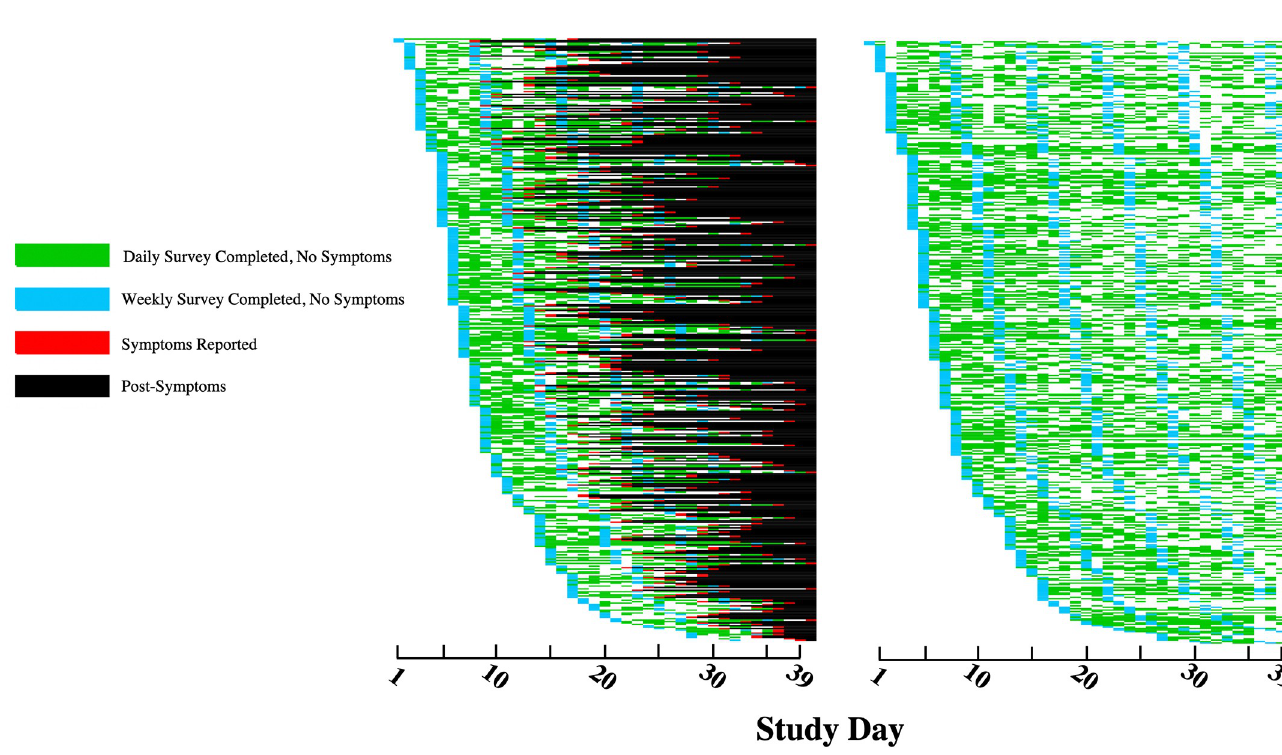
Fig 2. Heat map of symptomatic and sample of asymptomatic patients displaying time of enrollment, survey completion, time of symptom development, and follow-up. The left plot depicts participants that developed symptoms. The right plot depicts participants who did not develop symptoms matched in a one-to- one fashion with each symptomatic case by time of enrollment. Each row represents a unique study participant (n = 424 for each plot). The X-axis represents days of the current study. Blue = weekly survey completed (the first blue represents the enrollment visit). Green = daily survey completed (the daily survey contents are included in the weekly survey). Red = symptoms developed. Black = after development of symptoms. White = no data entry prior to or in the absence of symptoms.